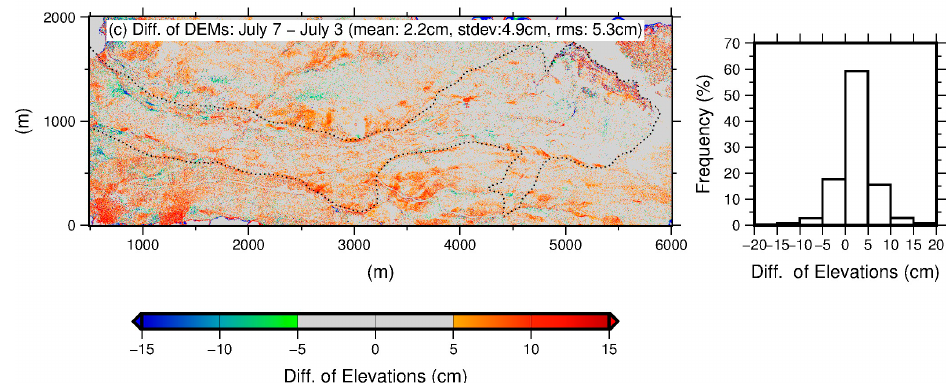
Figure 9. The elevation difference of two DEMs (DDEM, 0.5-m by 0.5-m) derived from bare-earth ALS datasets. ( a ) DDEM derived from ALS surveys on 10 July and 3 July; ( b ) DDEM derived from ALS surveys on 10 July and 7 July; ( c ) DDEM derived from ALS surveys on 3 July and 7 July. The black dotted line depicts the boundary of the landslide. The unit of the difference of elevations is a centimeter. The histogram illustrates the distribution of the values of the corresponding DDEM.